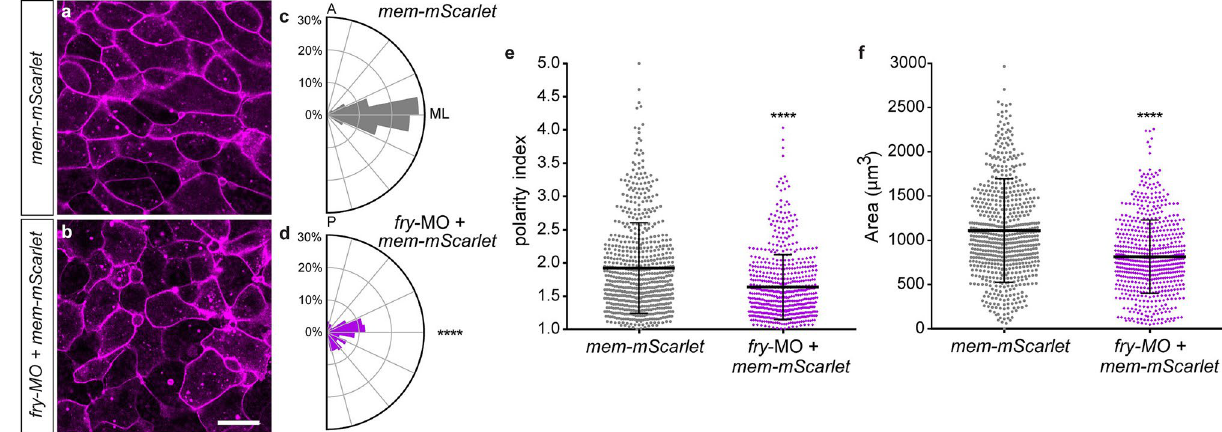
Figure 6. Loss of Fry affects morphological polarity and orientation of dorsal mesoderm cells. ( a,b ) Dorsal marginal zone explants were prepared from Xenopus embryos at early gastrula stage (St. 10.5) and the vegetal alignment zone (VgAZ) 5 , which corresponds to the axial mesoderm, was imaged at late gastrula stage (St. 13) to assess dorsal mesoderm cell morphology. ( a ) mem-mScarlet mRNA injected embryo (N = 2, n = 7). ( b ) fry- MO (15 ng) + mem-mScarlet mRNA co-injected embryo (N = 2, n = 7). N: number of independent experiments, n: number of explants. Scale bar: 100 μm. Representative explants are shown. ( c , d ) Cell orientation was quantified as the angle of the cell’s major axis with respect to the mediolateral axis (ML). The circles in the rose diagram refer to the percentage of cells that exhibited polarity angles for each bin. Orientation angles were binned from 0° to 90° in bins of 11.25°. A: anterior, P: posterior, ML: mediolateral. ( c ) mem-mScarlet mRNA injected embryo (total number of cells analyzed = 147). ( d ) fry- MO + mem-mScarlet mRNA co-injected embryo (total number of cells analyzed = 151). Statistically significant differences were found between groups, Chi -square test (**** p < 0.0001). ( e ) Polarity index measurements of dorsal mesoderm cells calculated as the ratio between cell major axis and minor axis. ( f ) Cellular area measurements of dorsal mesoderm cells. ( e,f ) mem-mScarlet mRNA injected embryos (total number of cells analyzed = 660); fry -MO + mem-mScarlet mRNA co-injected embryos (total number of cells analyzed = 632). Each point represents a single cell. Statistical significance was evaluated using two-tailed Mann Whitney U -test. **** p < 0.0001 indicates statistically significant differences between groups. Means and standard deviation are